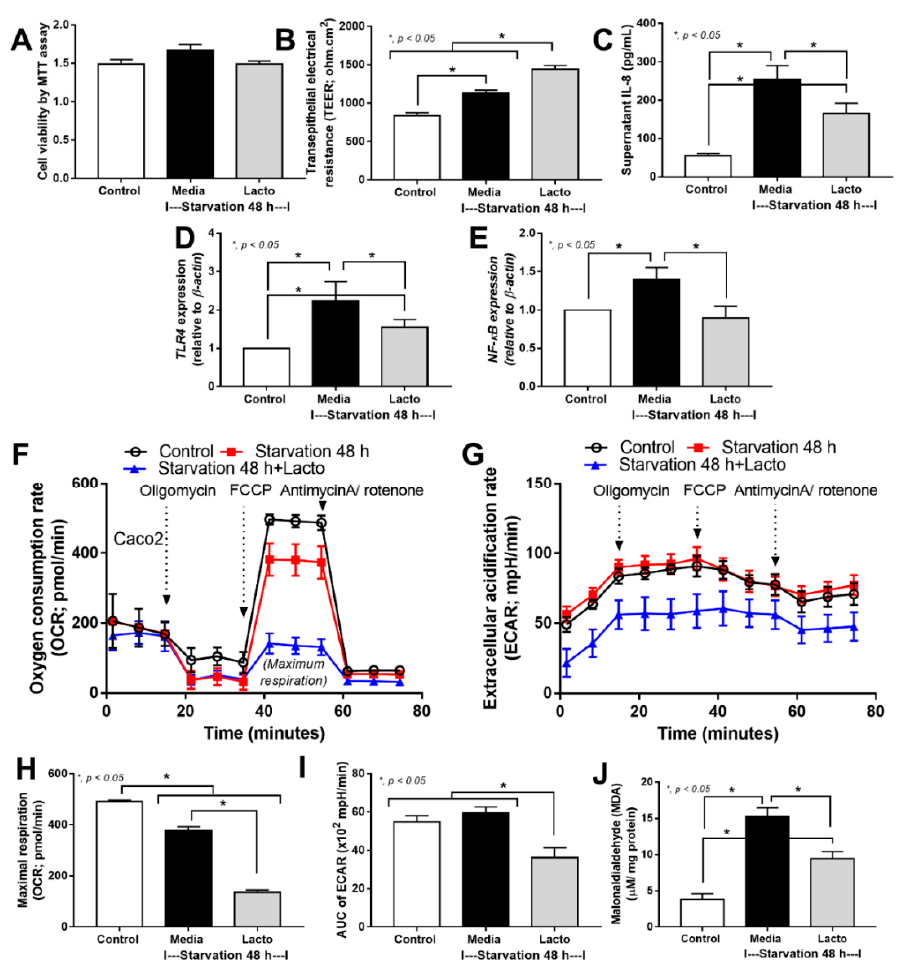
Figure 4. The characteristics of enterocytes (Caco-2 cell line) in control media versus the 48 h starvation with or without Lacticaseibacillus condition media (LCM) (Lacto) as indicated by cell viability test using 3-(4,5-dimethylthiazol-2-yl)-2,5-diphenyl-2H-tetrazolium bromide (MTT assay) ( A ), enterocyte integrity (transepithelial electrical resistance; TEER) ( B ), supernatant IL-8 ( C ), gene expression of inflammatory molecules, including Toll-like receptor 4 ( TLR4 ), nuclear factor kappa B ( NF- κ B ) ( D , E ), cell energy status as evaluated by the oxygen consumption rate (OCR; mitochondrial function), extracellular acidification rate (ECAR; glycolysis activity), maximal respiration (calculated from OCR), and the area under the curve (AUC) of ECAR ( F – I ), with malondialdialdehyde (MDA; a reactive oxygen species) ( J ) are demonstrated (independent triplicated experiments were performed).